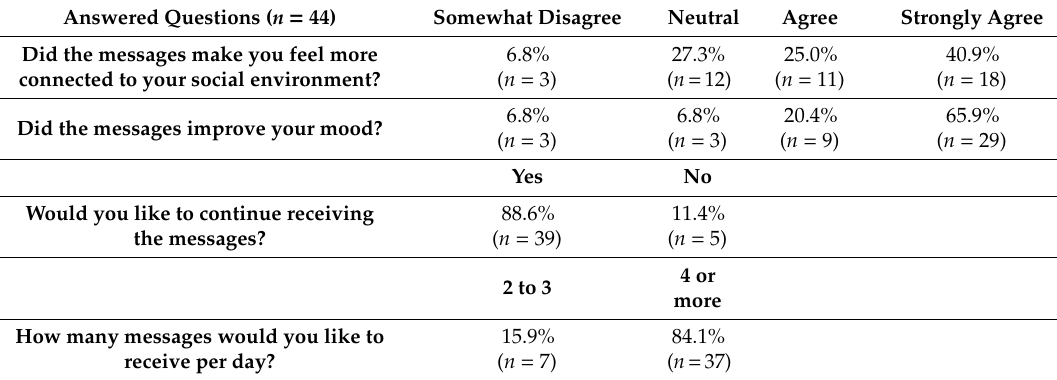
Table 2. Final questionnaire on text messages